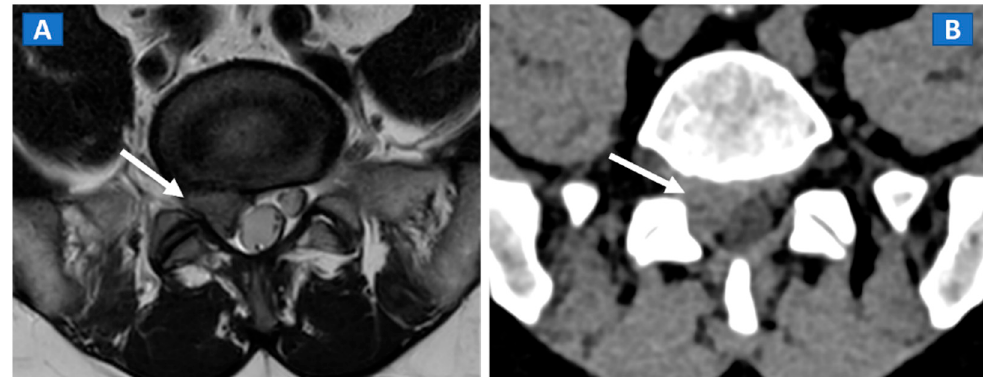
Figure 2. A 46-year-old male with non-traumatic, acute right sciatica pain. A large, right postero- lateral disk herniation (arrow) can be recognized at L5-S1 level both on the axial T2-weighted MR image ( A ) and on the corresponding axial 1 mm reconstructed CT image with a soft tissue window ( B ).